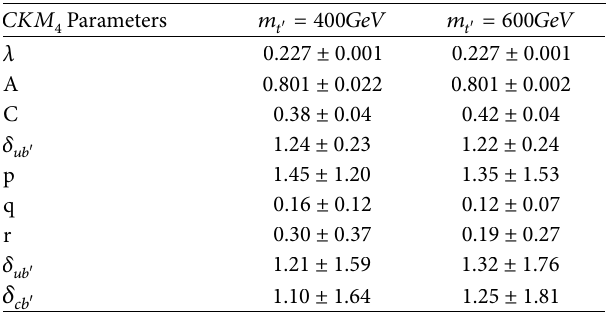
Table 2: The upper limits obtained from NO v A, MINOS, ma- 𝐶𝐾𝑀 4